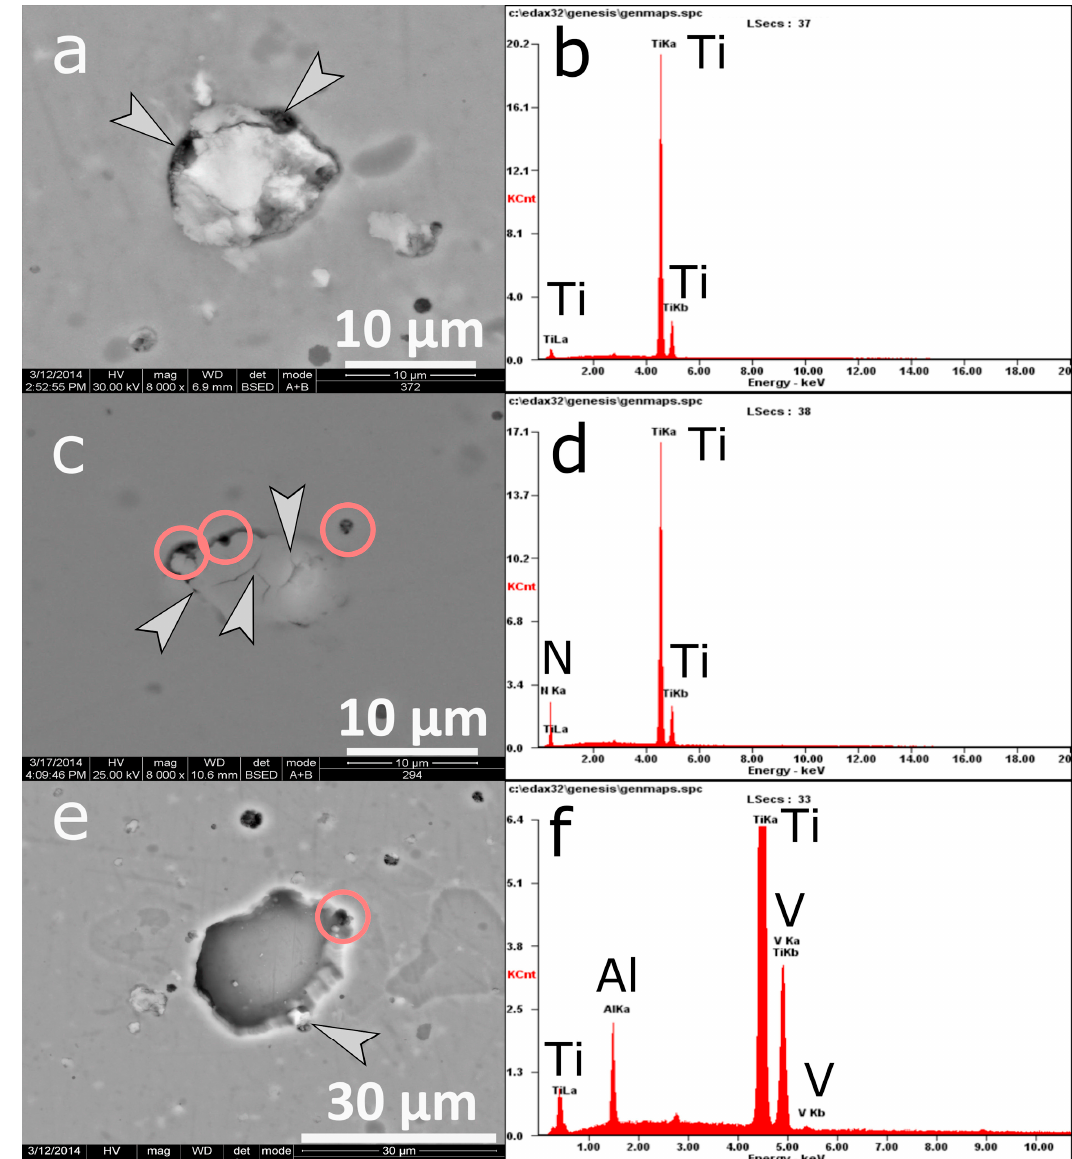
Figure 9. SEM micrographs of defects observed in TiN-coated Ti6Al4V. ( a ) Titanium droplet embedded into the coating; the arrows indicate missing coating adjacent to the droplet; ( b ) EDX analysis of the droplet; ( c ) cracking of coating adjacent to pinholes (in circles); ( d ) EDX analysis of cracked coating; ( e ) blister with debonded coating, formed adjacent to a pinhole (in the circle) and a titanium droplet (arrow); ( f ) EDX analysis of the bottom of a blister demonstrating the composition of the TiAl6V4 substrate alloy. Reproduced from [ 120 ] .